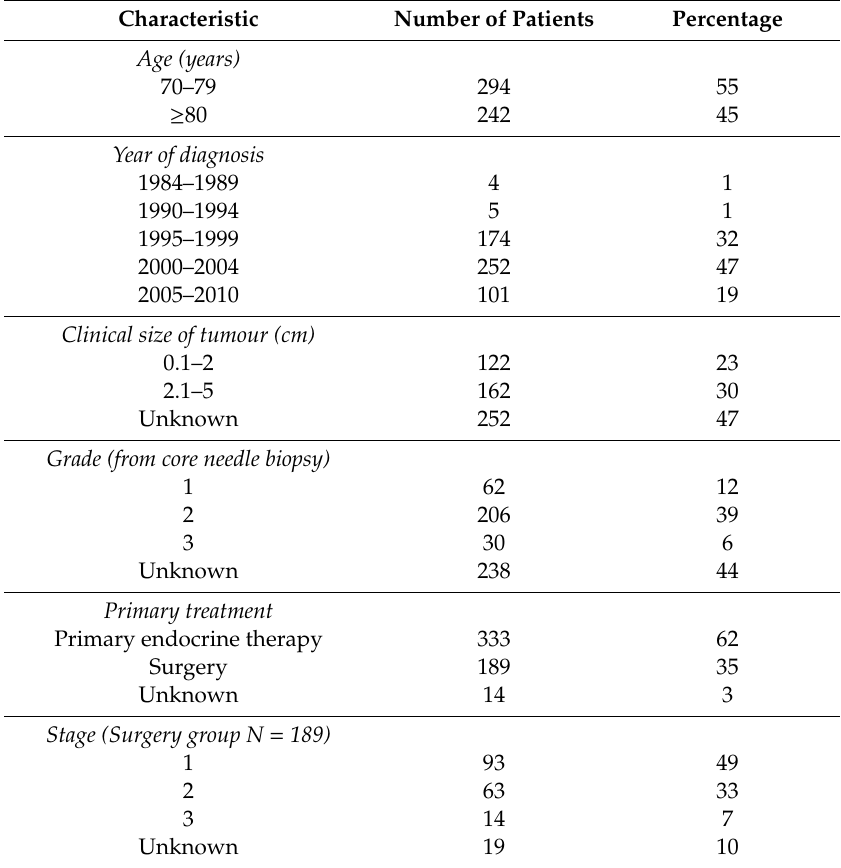
Table 1. Patients and tumour characteristics of ER-positive tumours in older women.